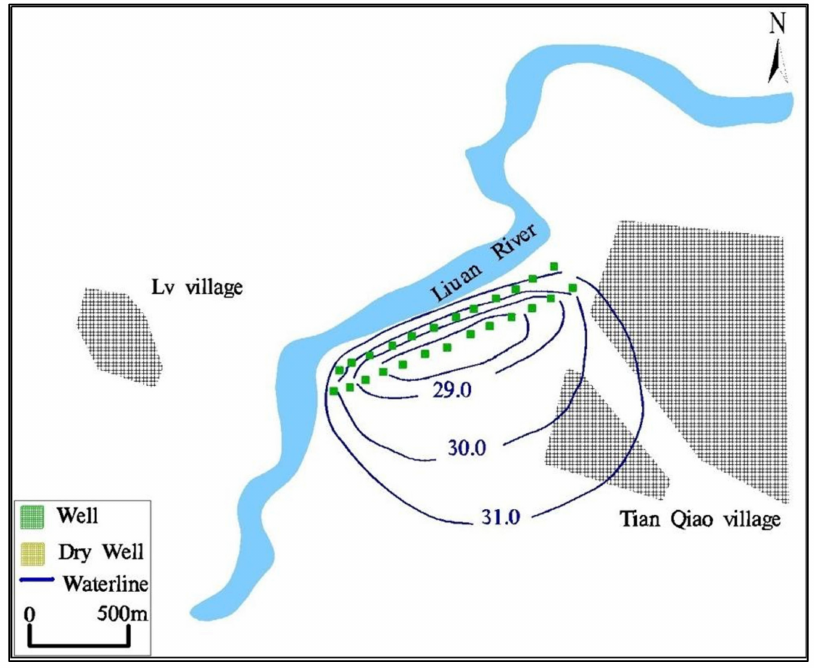
Figure 11. Water level flow field 60 days after pumping.